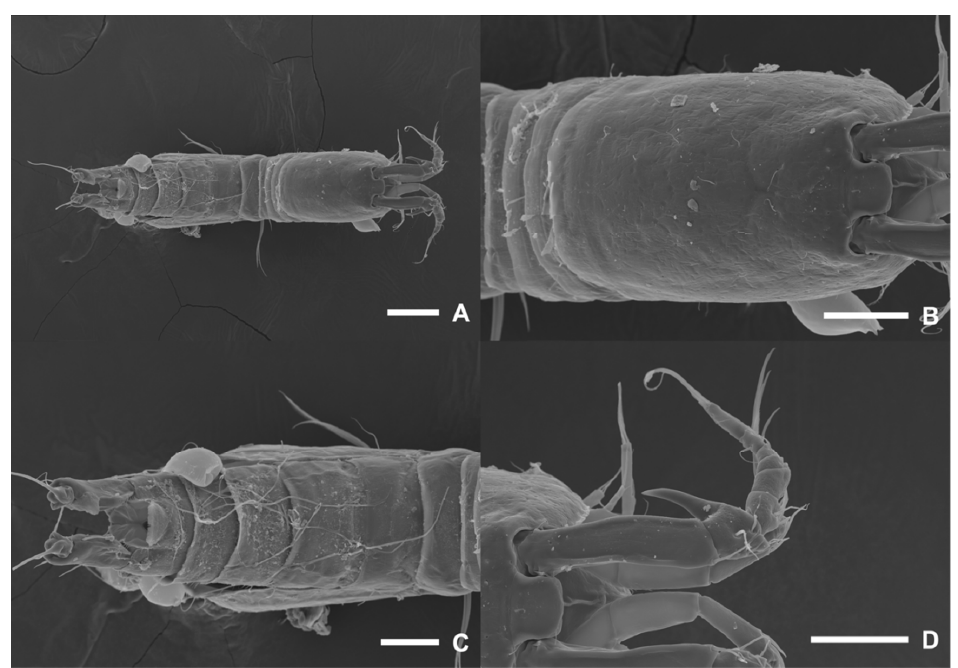
Figure 3. Scanning electron microscopy images of Phyllopodopsyllus saywakimi sp. nov. female (paratype 2) in dorsal view: ( A ) habitus; ( B ) prosome; ( C ) urosome; ( D ) antennule and rostrum. Scale bars: ( A ) 100 µm; ( B – D ) 50 µm.